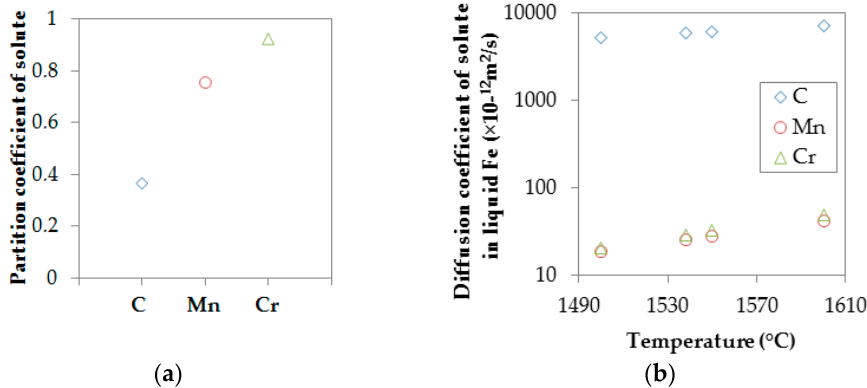
Figure 2. ( a ) Partition coefficients of different alloying elements determined based on linearized binary phase diagrams with respect to iron; ( b ) Evolution of diffusion coefficients of solutes in liquid iron as a function of temperature.